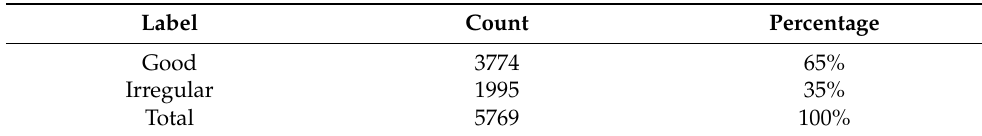
Table 1. Walking surface label distribution.